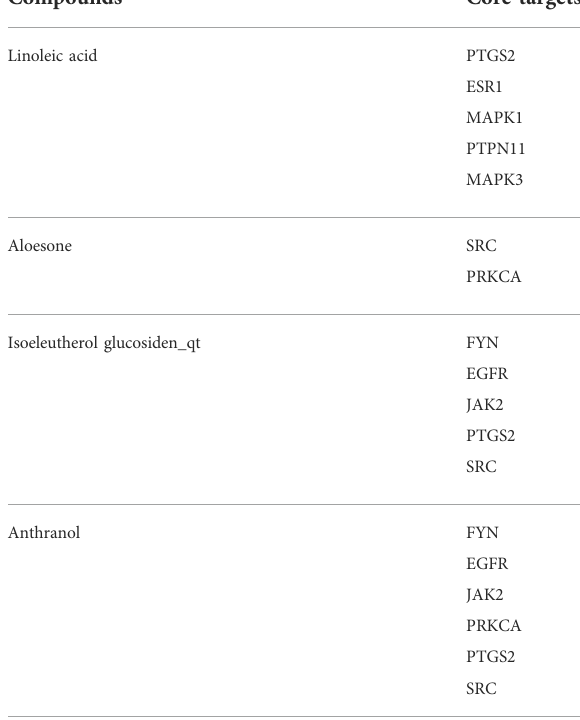
TABLE 2 The core targets of linoleic acid, aloesone, isoeleutherol glucosiden_qt, and anthranol.